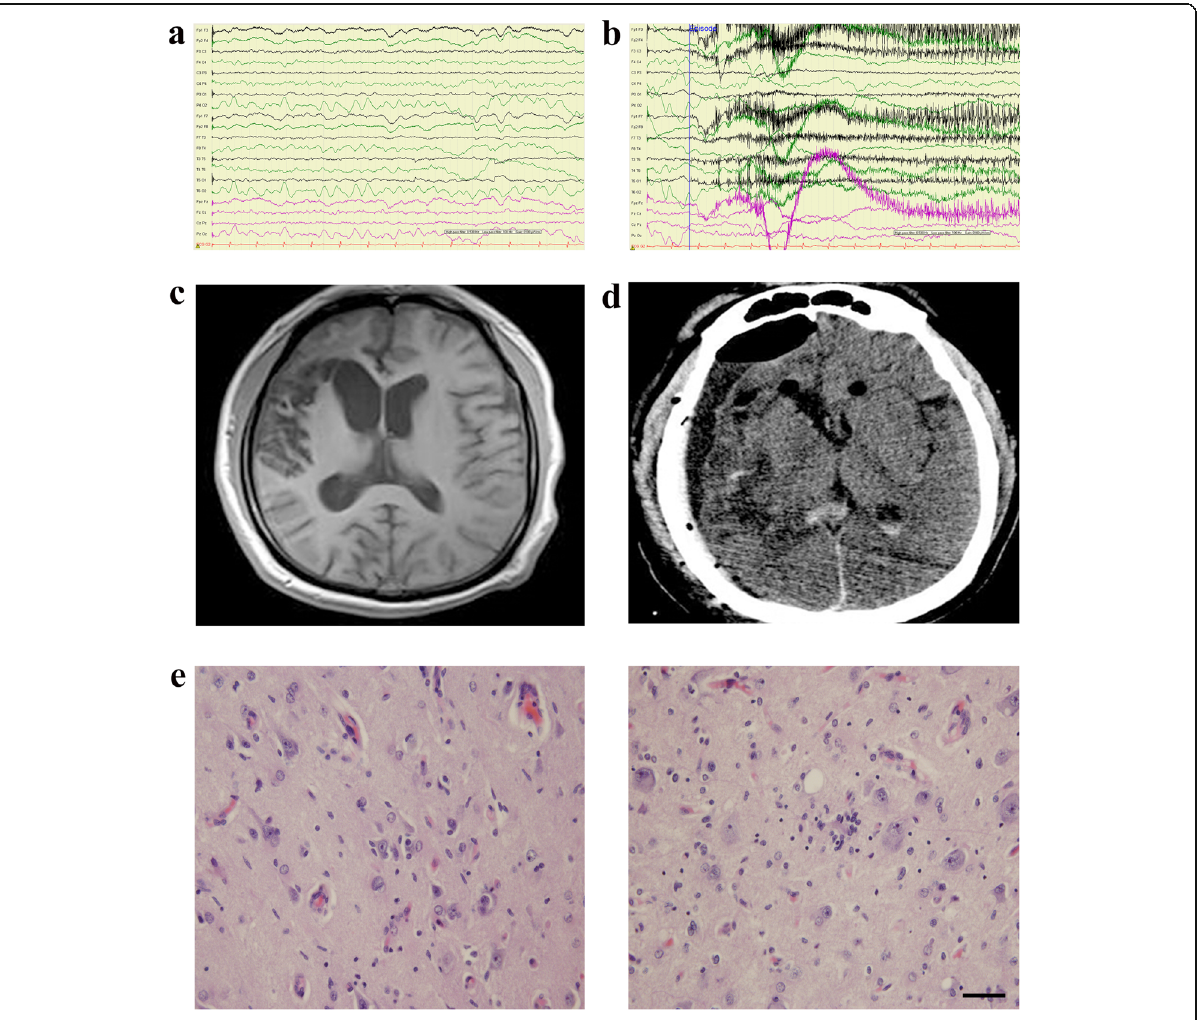
Fig. 1 Clinical data of case 1. a Interictal EEG showed slow wave on the right temporal and parietal regions. b Ictal EEG showed the electromyographic artifact and reduced electrical activity on the right hemisphere. c Axial MRI showed atrophy of the right hemisphere. d Post- operative CT. e Pathological images showed diffuse infiltration of microglia lymphocytes and neuronophagia phenomenon. Scale bar: 50 μ